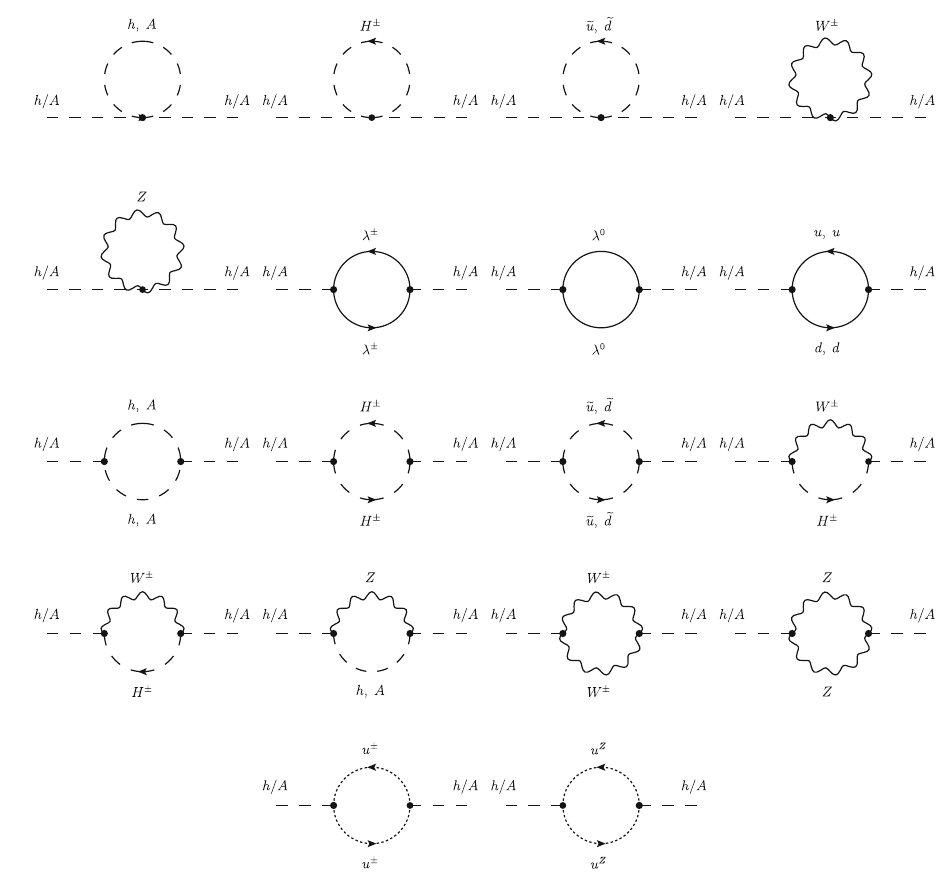
Fig. 3 Generic diagrams for the CP -even ( h ) and CP